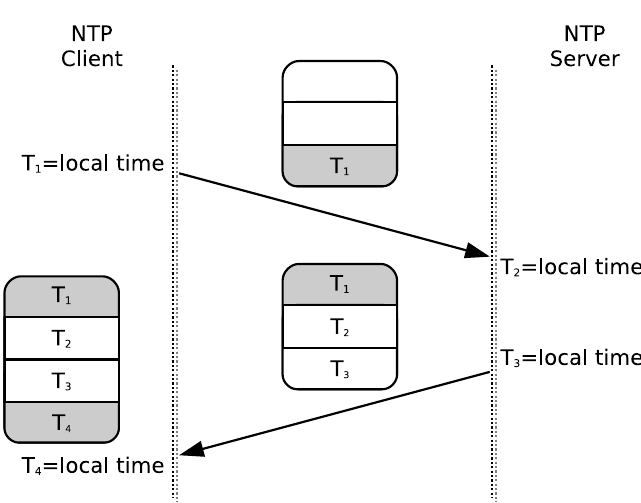
Figure 2. On-wire network time protocol (NTP)